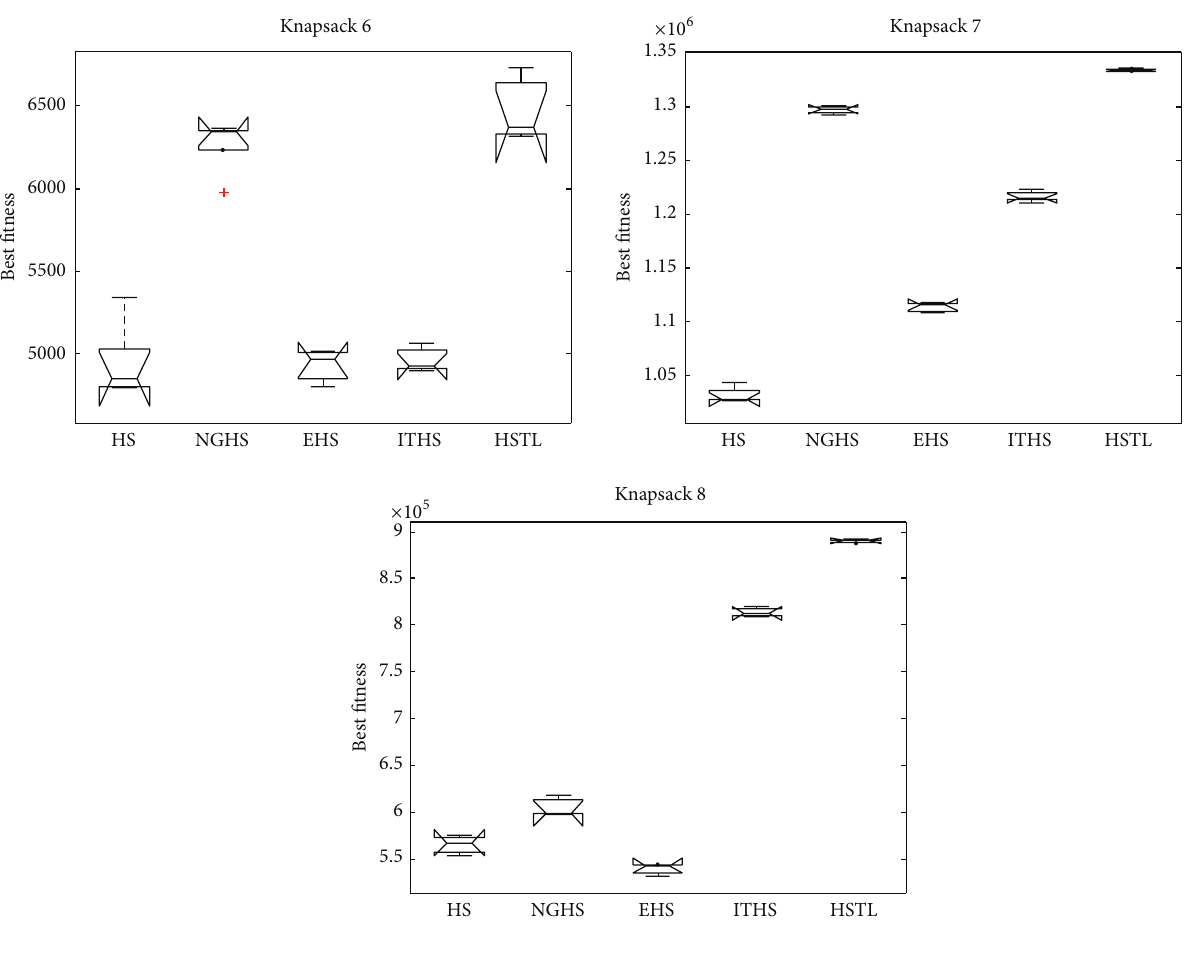
Figure 7: The box plots of KP 6 –KP 8